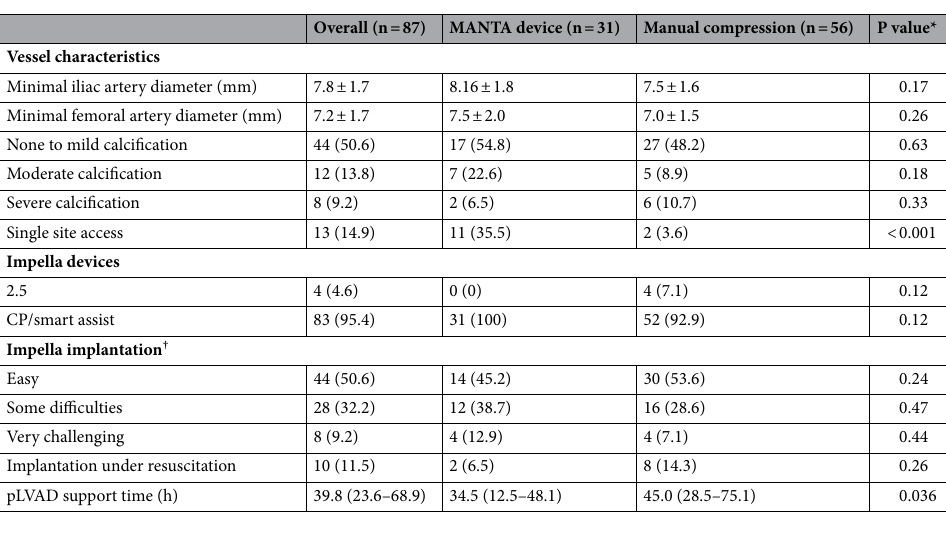
Table 2. Access and device-related characteristics. Data are median (interquartile range) or number (percentage), as appropriate. pLVAD = percutaneous left ventricular assist device. * P values were based on Man-Whitney-U test or t test as appropriate. † This was defined based on the feedback from the interventionalist involved in the procedure and/or presence of procedure related complications.